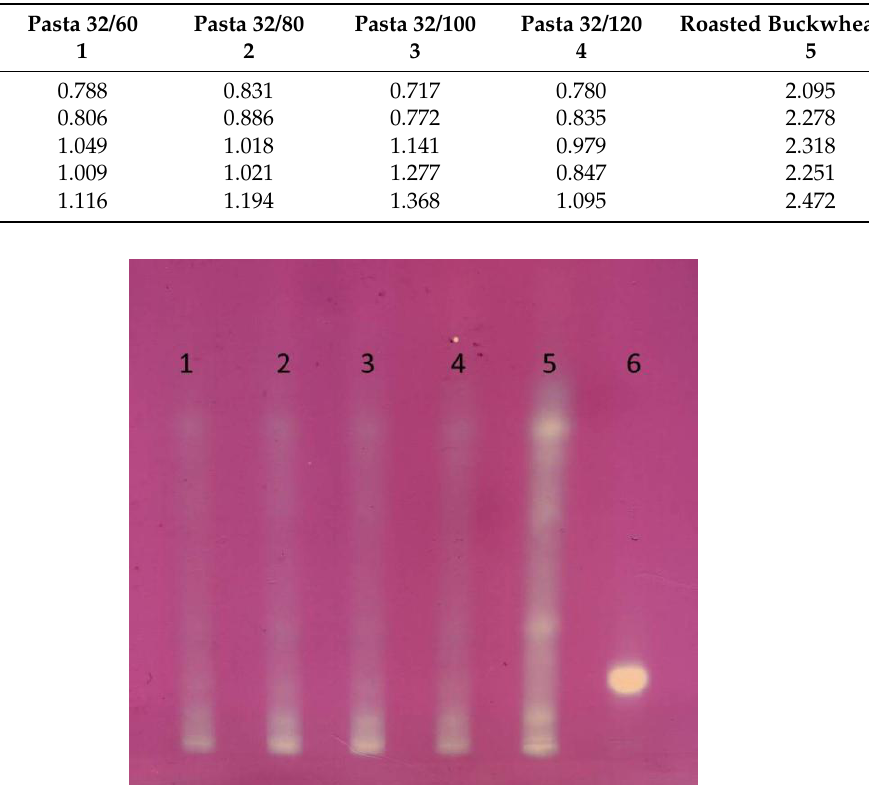
Figure 1. Results of TLC-DPPH; scan after 30 min. Mobile phase: acetonitrile, water, chloroform, formic acid (30:2:5:2, v / v / v / v ). 1—pasta 32/60, 2—pasta 32/80, 3—pasta 32/100, 4—pasta 32/120, 5—